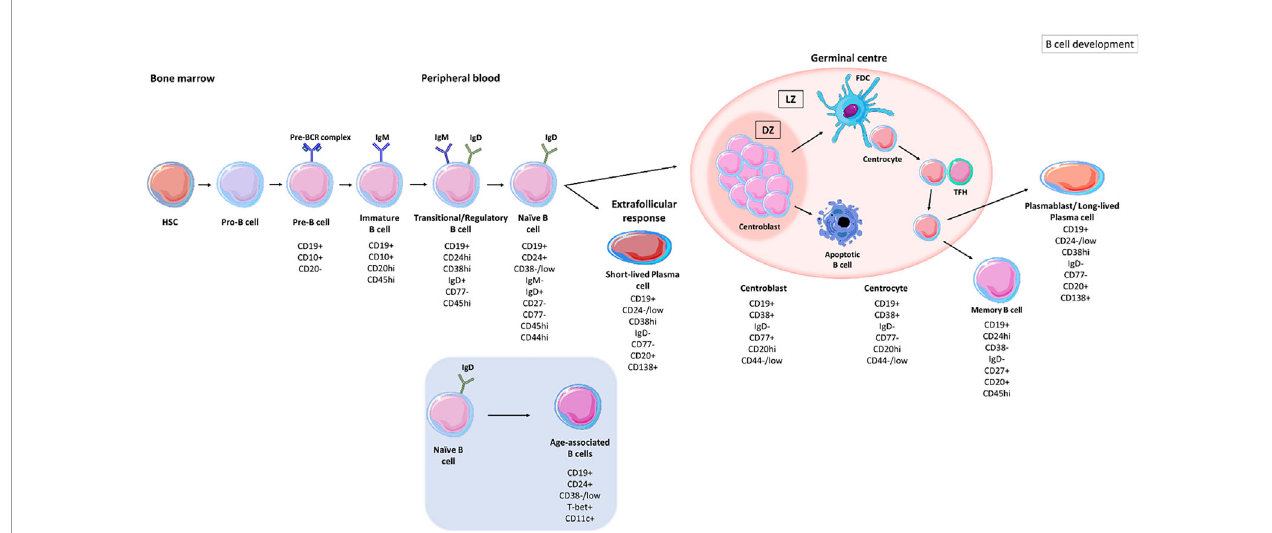
FIGURE 1 | B cell development stages. B cells develop in the bone marrow from haematopoietic stem cells (HSCs), progressing from pro-B cell stages to pre-B cells before migrating into the circulation as transitional B cells. Upon antigen recognition, activated B cells migrate to secondary lymphoid organs and enter germinal centres where they undergo clonal expansion and somatic hypermutation (SHM) within the dark zones (DZ). B cells with disadvantageous mutations die by apoptosis whereas those B cells with improved receptor af fi nity interact with follicular dendritic cells (FDC) and T follicular helper cells (TFH), in the light zone (LZ). B cells undergo class switch recombination (CSR) and receive survival signals to differentiate into memory B cells and long-lived plasma cells (PCs) (5). Naïve B cells can differentiate into short-lived plasma cells through extrafollicular responses (6). Naïve B cells can also differentiate into age-associated B cells (ABCs) upon stimulation